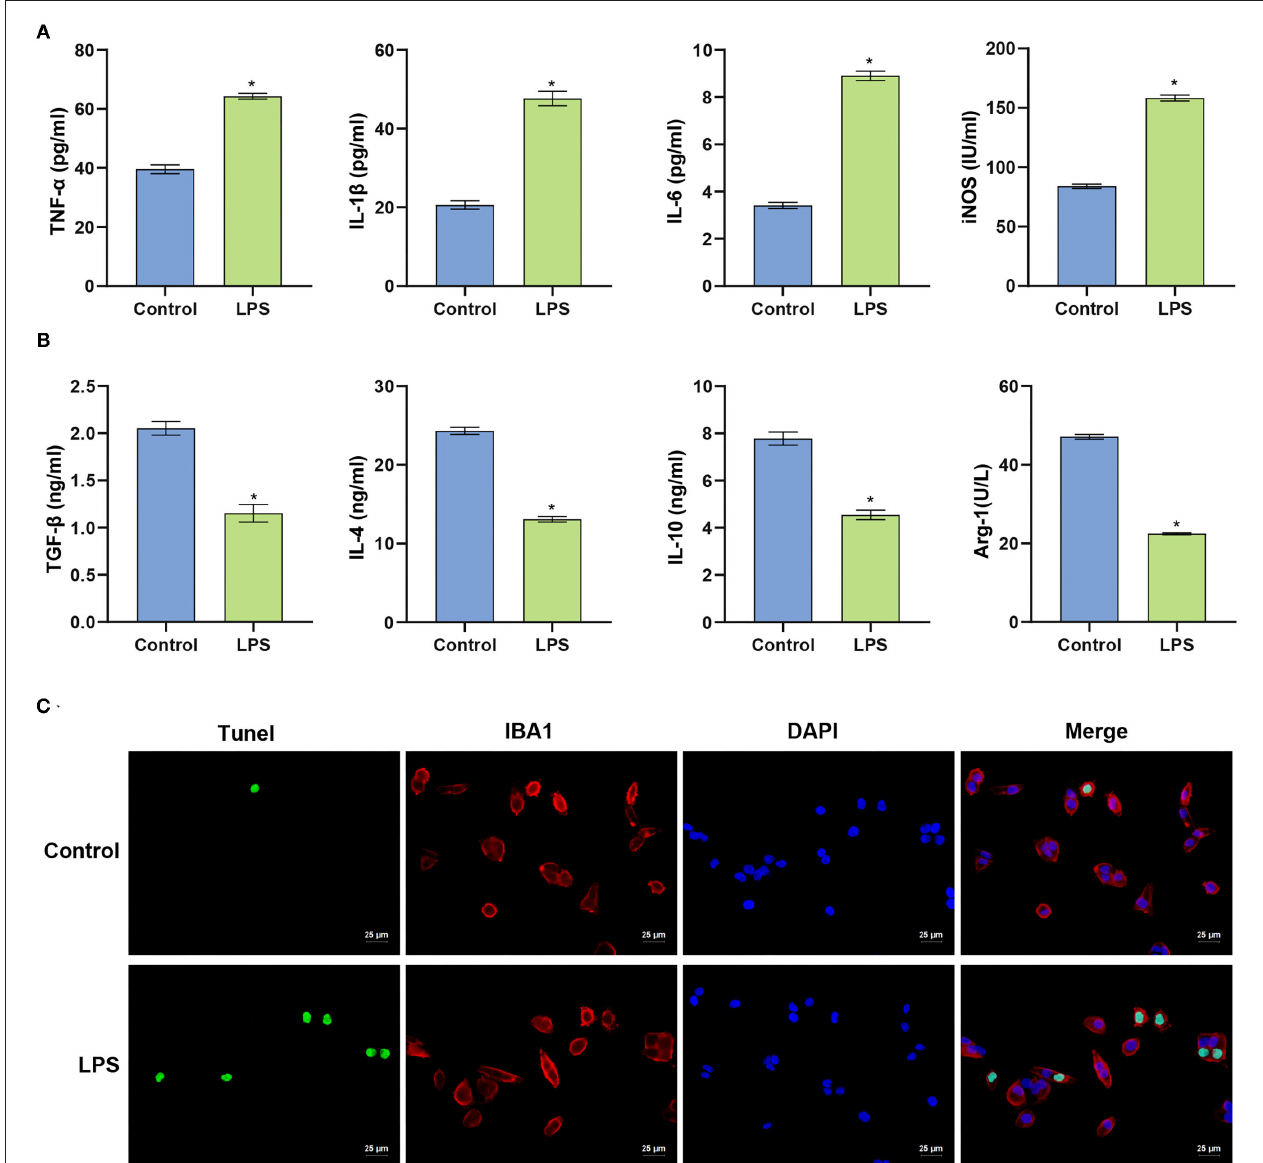
FIGURE 1 | LPS induces apoptosis of BV2 cells. (A) Level of the measured pro-inflammatory factors in BV2 cells. (B) ELISA determination of the levels of anti-inflammatory factors in BV2 cells. (C) TUNEL assay (Scale bar = 25 µ m). The unpaired t -test was used to analyze comparisons between two groups. * P < 0.05 compared with the control